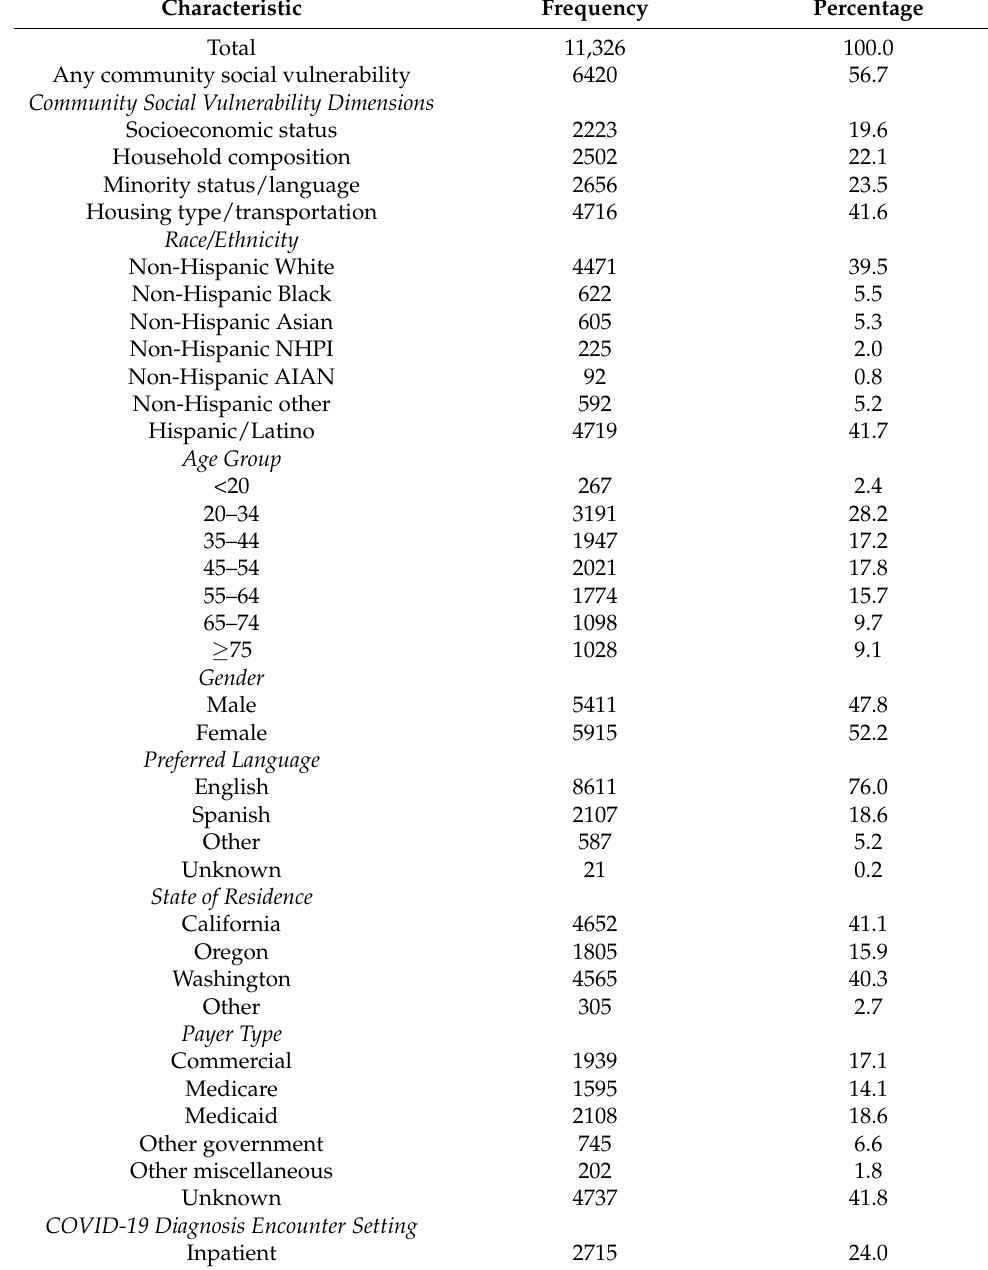
Table 1. Characteristics of the study